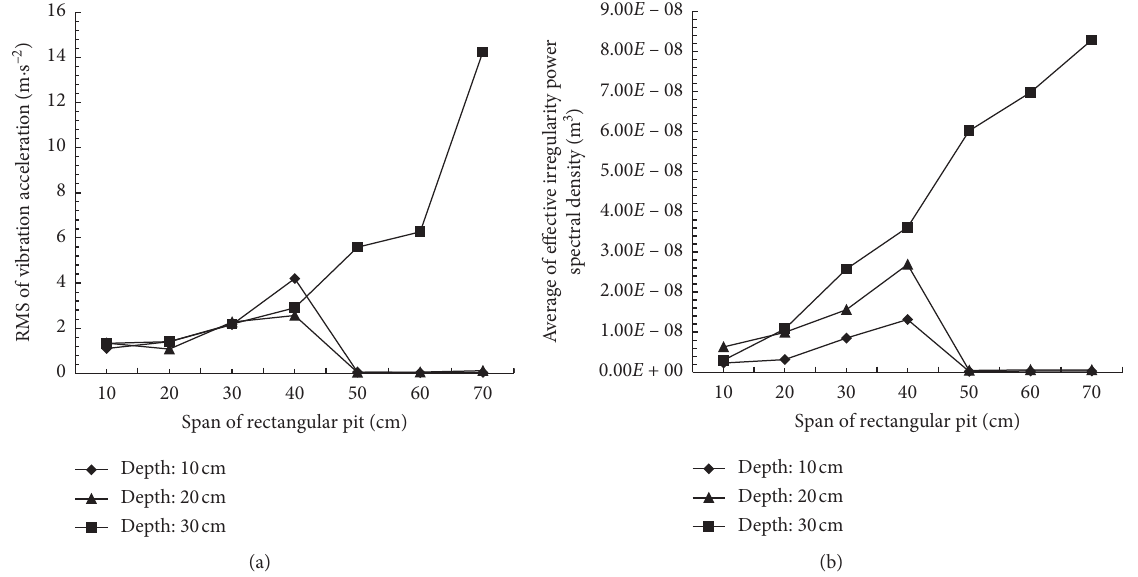
Figure 12: Vibration response and road excitation law. (a) RMS of vibration acceleration, (b) Average of effective irregularity power spectral